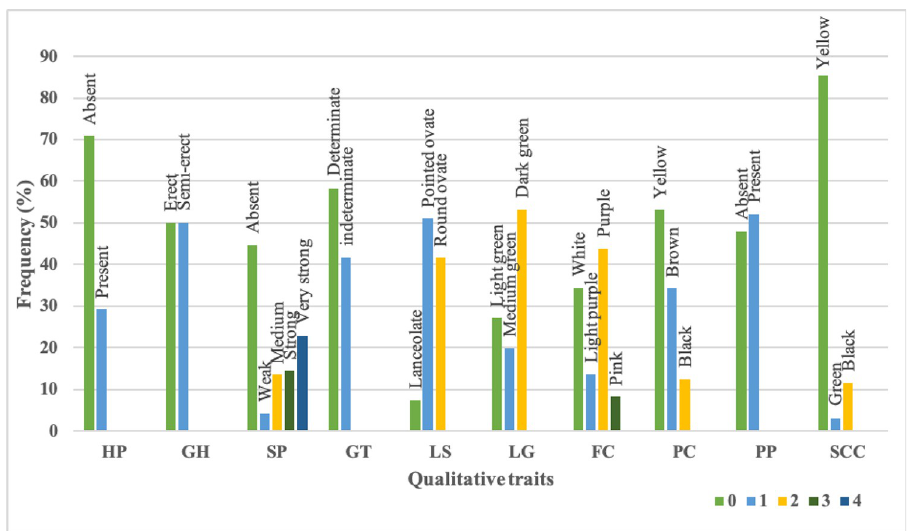
Fig 7. Number of genotypes for each class in different qualitative traits. ( HP : Hypocotyl anthocyanin pigmentation (0: Absent; 1: Present), GH : Growth habit (0: Erect; 1: Semi-erect), SP : Stem pubescence (0: Absent; 1: Weak; 2: Medium; 3: Strong; 4: Strong), GT : Growth type (0: Determinate; 1: Indeterminate), LS : Leaf shape (0: Lanceolate; 1: Pointed ovate; 2: Round ovate), LG : Leaf greenness (0: Light green; 1: Medium green; 2: Dark green), FC : Flower colour (0: White; 1: Light purple; 2: Purple; 3: Pink), PC : Pod colour (0: Yellow; 1: Brown; 2: Black), PP : Pod pubescence (0: Absent; 1: Present) and SCC : Seed coat colour (0: Yellow; 1: Green; 2: Black).